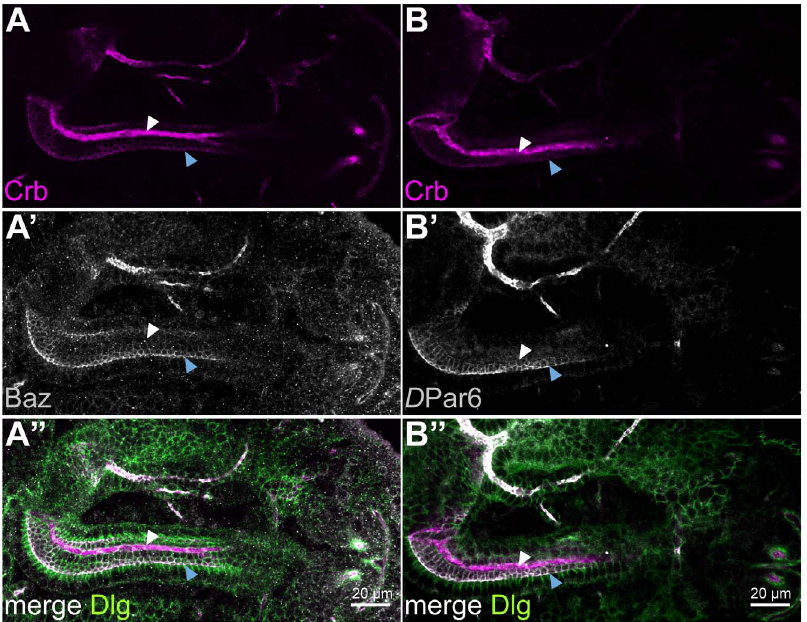
Figure 2. Localisation of apical and baso-lateral polarity proteins is not altered in BCs. Confocal microscope images of stage 15 wild-type embryonic hindguts (BCs: white arrowheads, PCs: blue arrowheads). Anterior is left. ( A–A 0 ) Hindgut stained for the polarity markers Crb (magenta), Baz (grey) and Dlg (green). Only Crb is upregulated in the BCs (A and A 0 ), while Baz (A 9 and A 0 ) and Dlg (A 0 ) show the same amount and localisation as in the PCs. ( B–B 0 ) Hindgut stained for the polarity markers Crb (magenta) and D Par6 (green). Crb is enriched in the BCs (B and B 0 ) but D Par6 localises only to the SAR as in the PCs (B 9 and B 0 ).